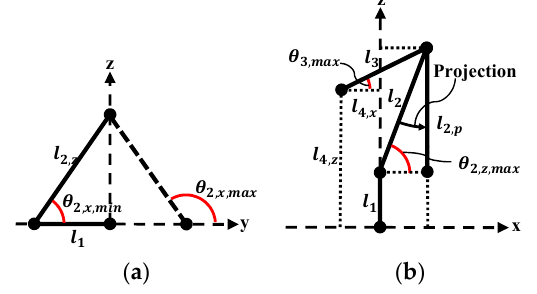
Figure 10. ( a ) Projected on the y - z plane; ( b ) projected on the x - z plane of flapping mechanism.